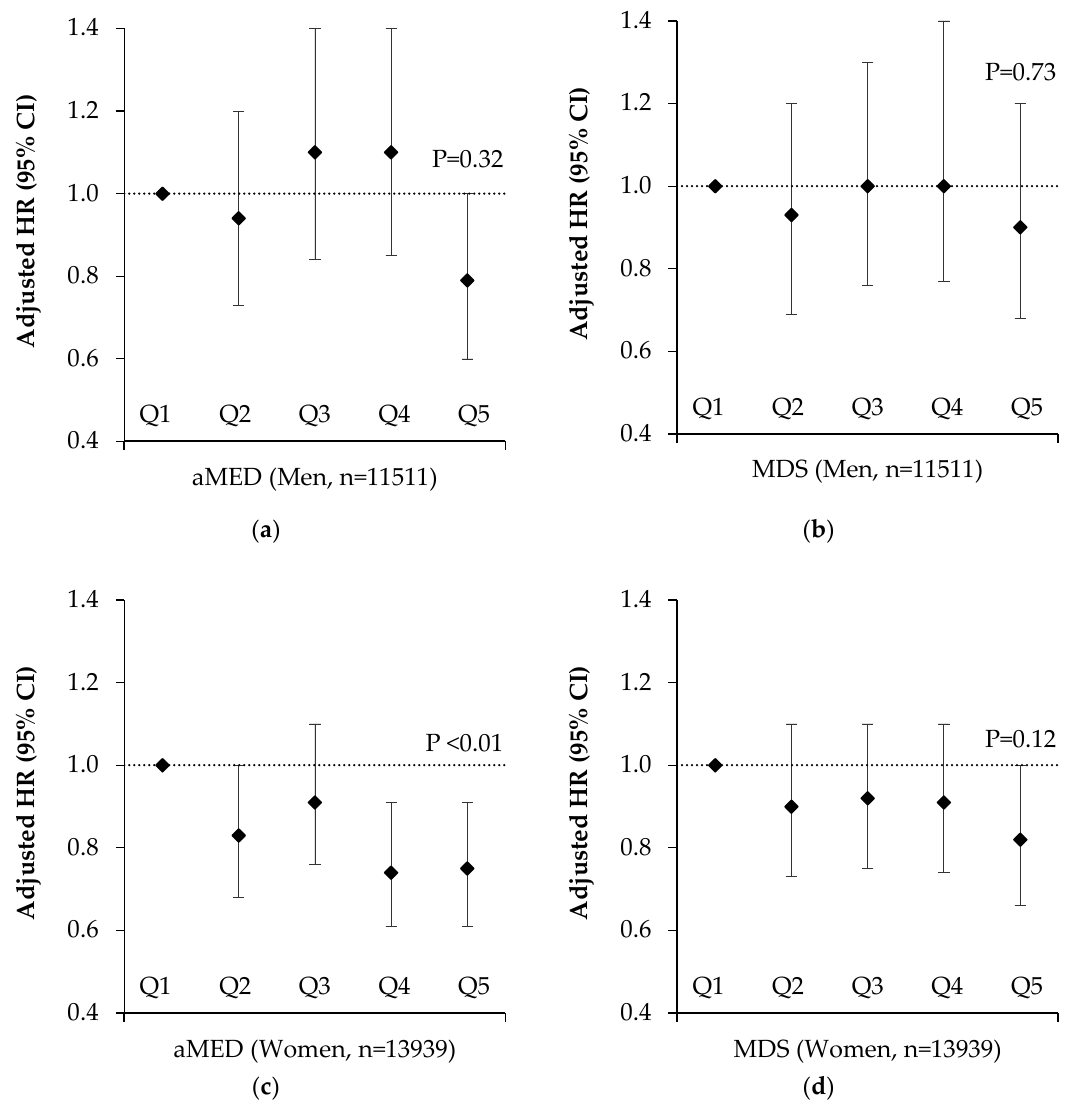
Figure 4. Total fracture risk after a mean follow up of 17.6 years by quintile of alternative Mediterranean Diet Score and Mediterranean Diet Score in 25,450 men and women aged 39 – 79 years stratified by sex. Values are adjusted hazard ratios (95% CI), n = 25,450. Ratios were adjusted for age, BMI, smoking, physical activity, family history of osteoporosis, calcium intakes, supplement use (vitamin D or calcium), medication use (corticosteroids, aspirin or hormone replacement therapy), menopausal status, days of dietary intake data and the ratio of energy intake to estimated energy requirements. P values are for trends calculated using the Cox proportional hazards model. Participant numbers (cases) per quintile were as follows; ( a ) aMED Males: Q1 = 2300 (121), Q2 = 2236 (111), Q3 = 2522 (145), Q4 = 2162 (131), Q5 = 2291 (102) ( b ) MDS Males: Q1 = 1397 (75), Q2 = 2070 (103), Q3 = 2637 (145), Q4 = 2626 (150), Q5 = 2781 (137) ( c ) aMED Females: Q1 = 2861 (360), Q2 = 2755 (319), Q3 = 3035 (370), Q4 = 2578 (265), Q5 = 2710 (271) ( d ) MDS Females: Q1 = 1907 (242), Q2 = 2709 (313), Q3 = 3281 (383), Q4 = 3055 (344), Q5 = 2987 (303). aMED = alternative Mediterranean Diet Score, MDS = Mediterranean Diet Score. Of the individual components of the aMED score, intakes above the median of legumes (HR 0.91; 95% CI 0.84, 0.99; P -trend = 0.04), nuts and seeds (HR 0.86; 95% CI 0.77, 0.96; P -trend = 0.01), and